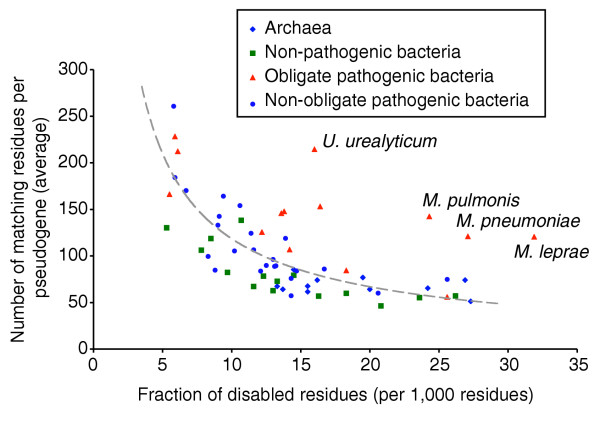
The fraction of disabled residues (per 1,000 residues) versus the number of average matching residues to the closest homologs per pseudogene in the 64 species categorized into four groups: archaea (blue diamonds), non-pathogenic bacteria (green squares), obligate pathogenic bacteria (purple circles) and non-obligate pathogenic bacteria (red triangles).